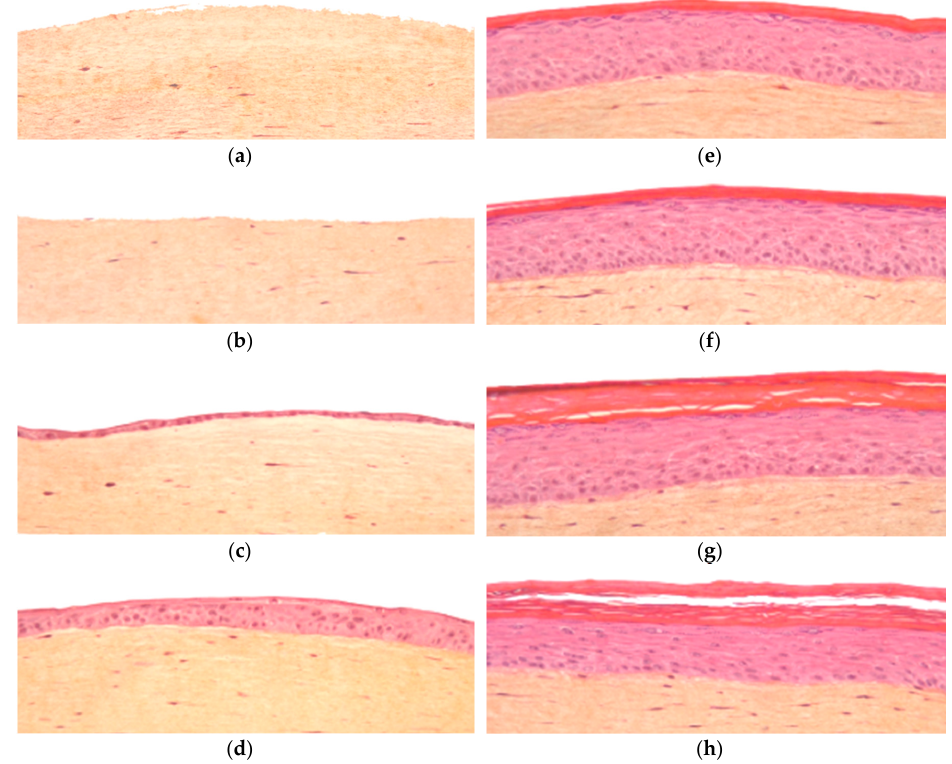
Figure 1. Kinetic of T-Skin™ model histology studied by hematoxylin-eosin-safran staining over 25 days: ( a ) day 1; ( b ) day 5 ( c ) day 8; ( d ) day 13; ( e ) day 18; ( f ) day 20; ( g ) day 22 and ( h ) day 25.